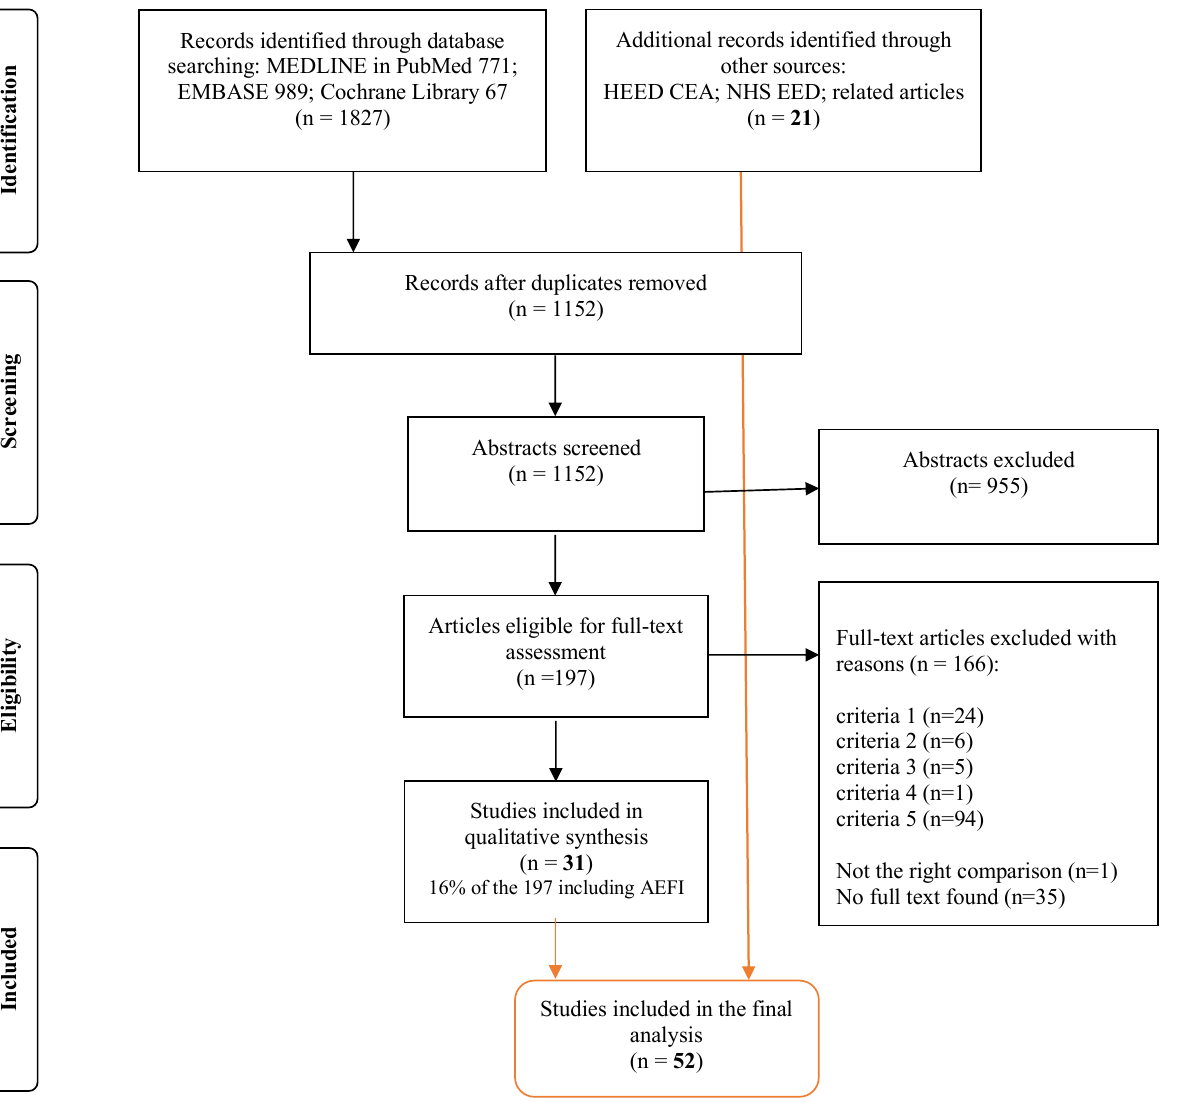
Figure 1. Preferred Reporting Items for Systematic Reviews and Meta-Analyses (PRISMA) flow diagram. NHS